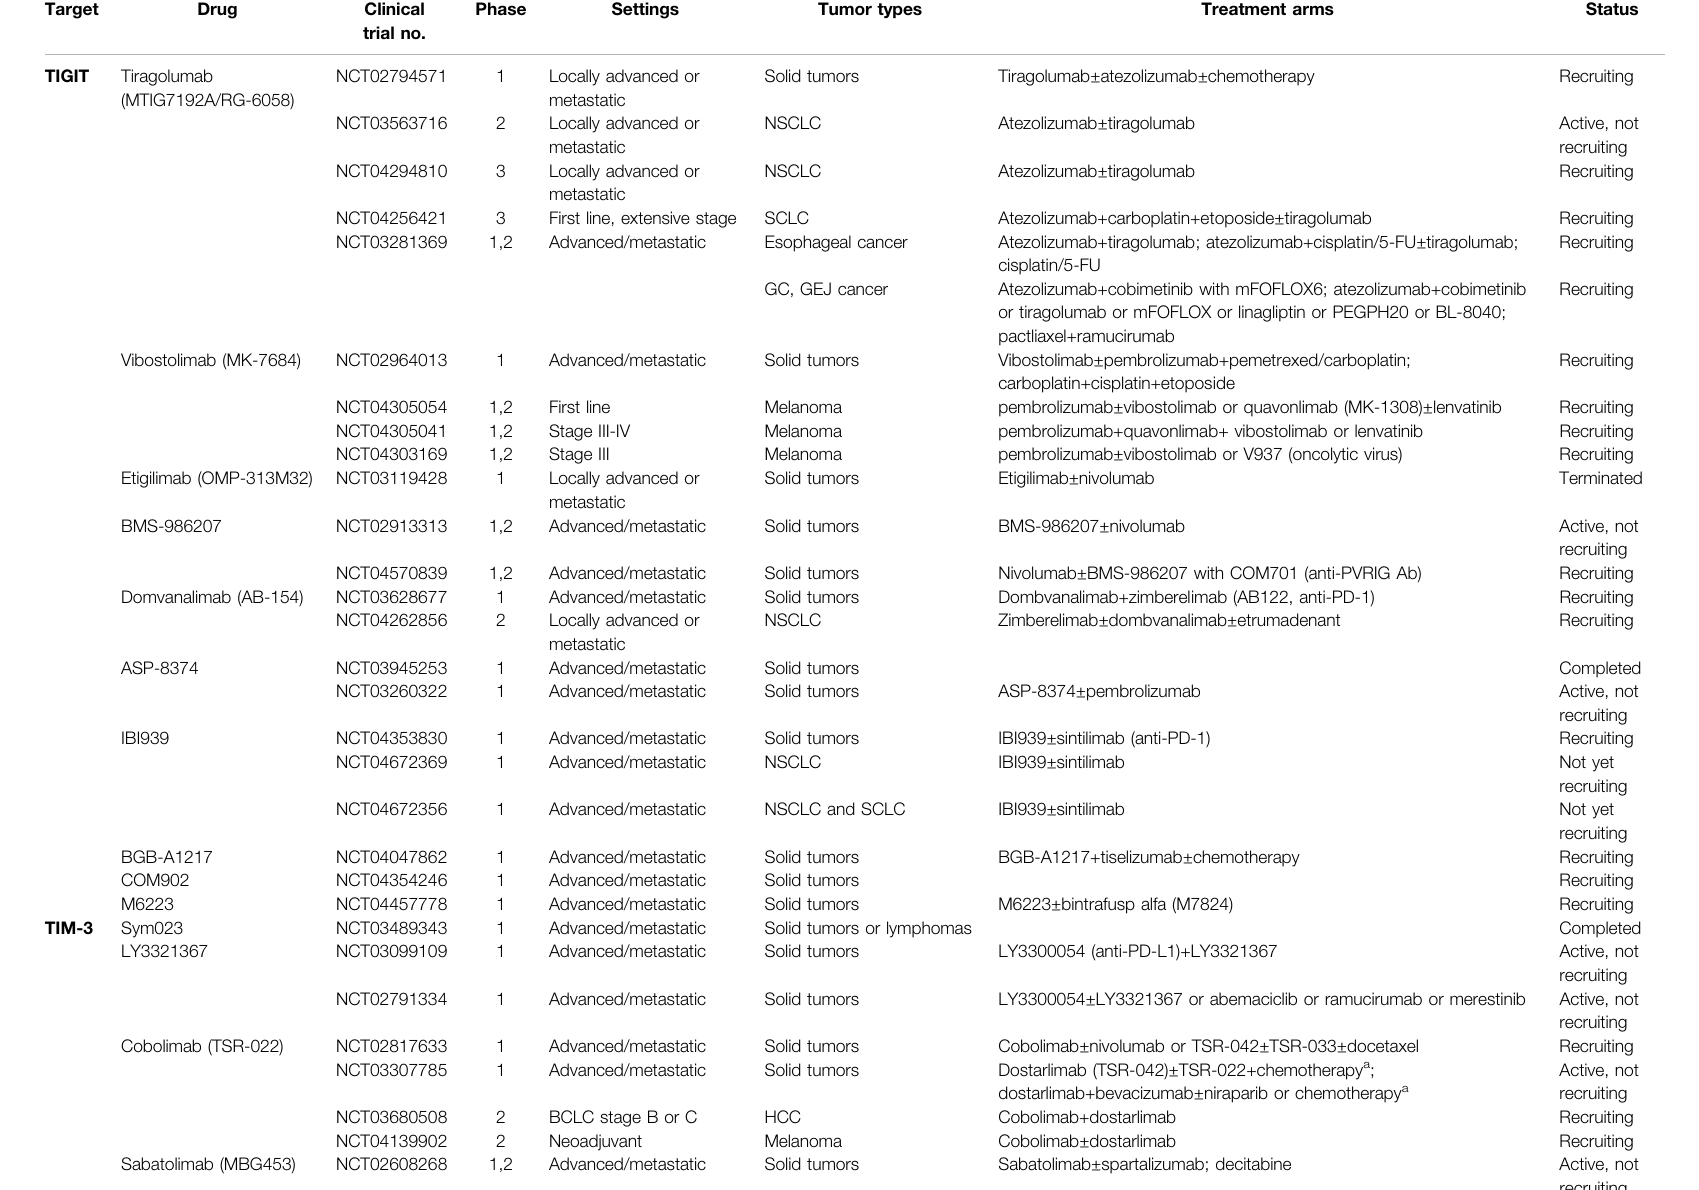
TABLE 3 | ( Continued ) Clinical trials on novel immune checkpoint